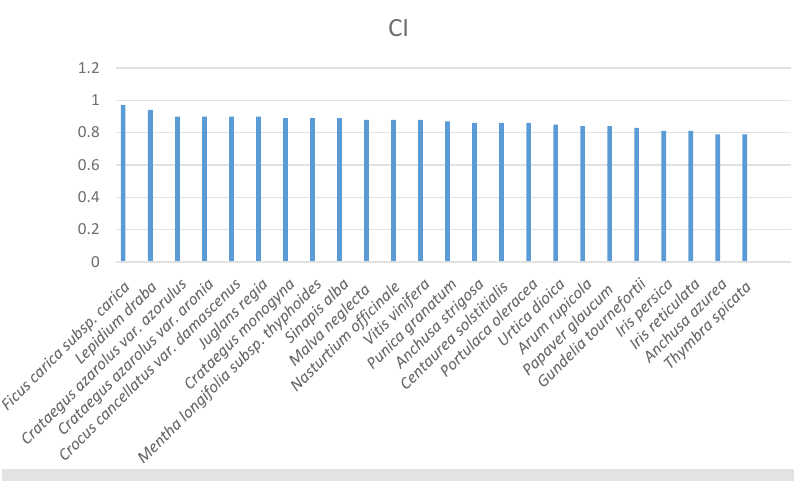
Fig. 10 The highest cultural importance (CI) index of the 24 most relevant